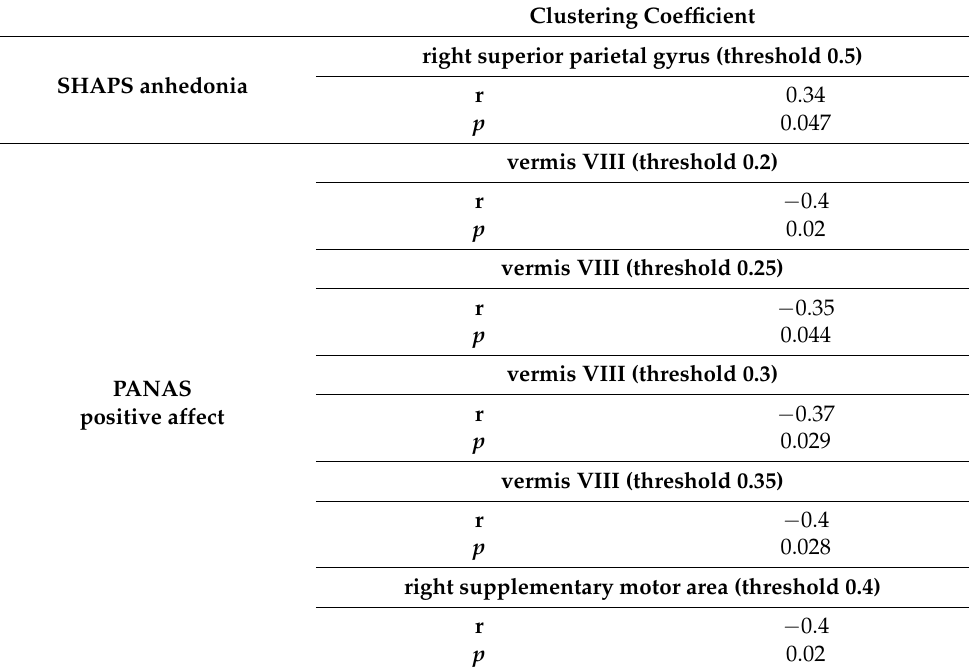
Table 4. Significant correlations between significant between-session differences in clustering coeffi- cient and psychological features.